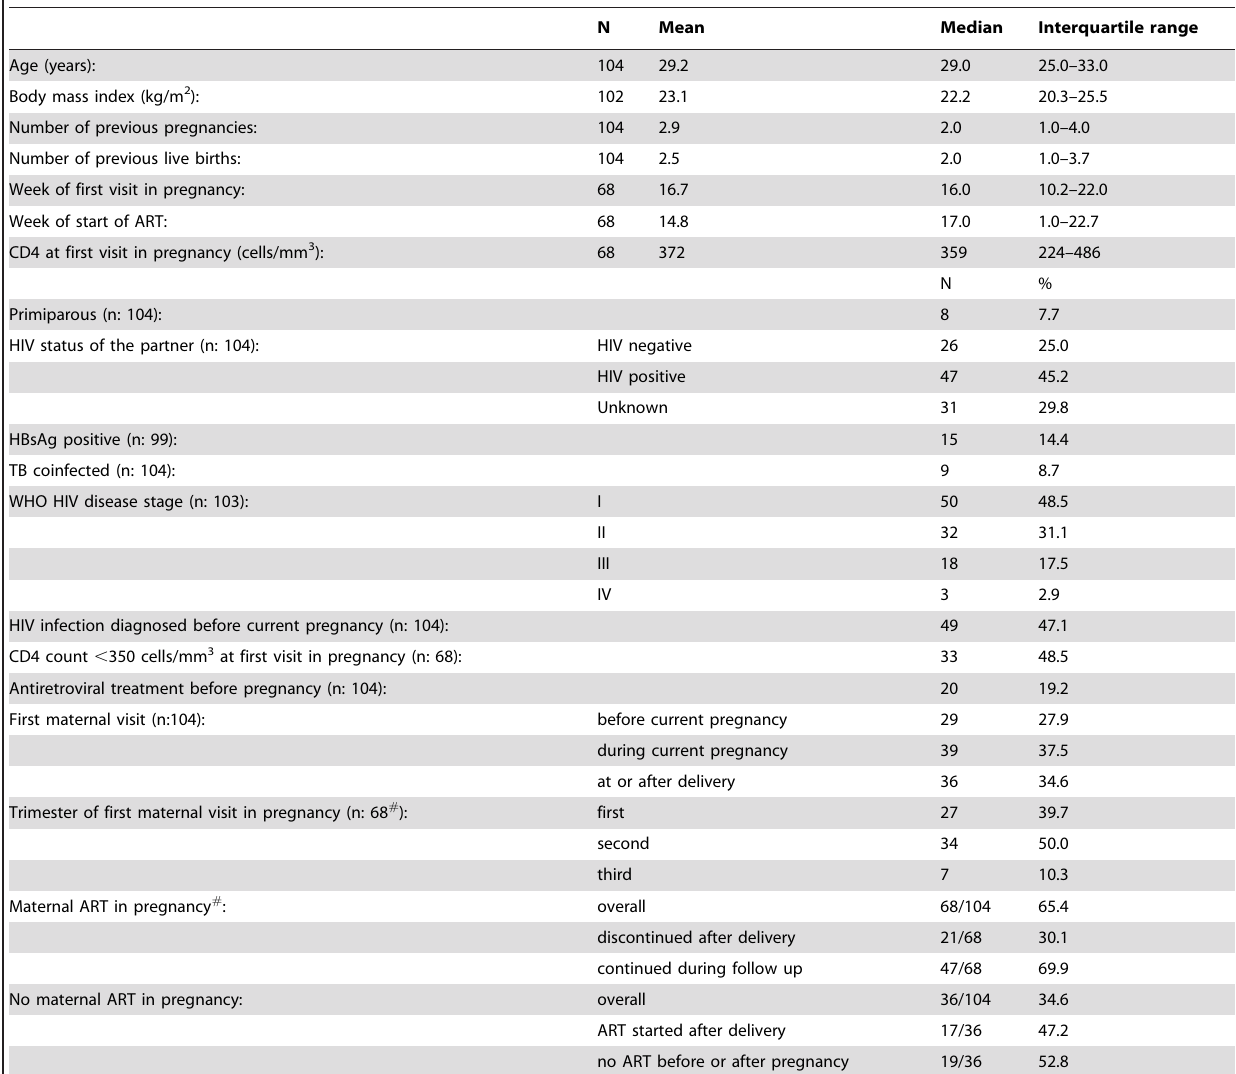
Table 1. General characteristics.